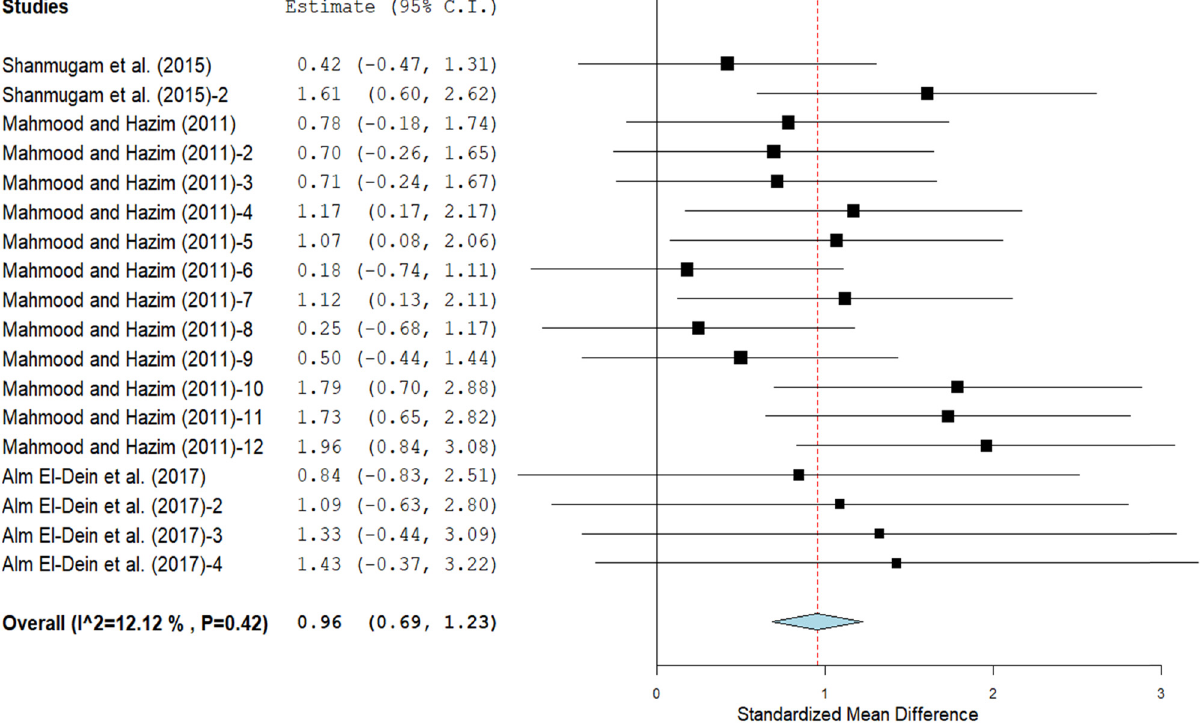
Figure 5: Impact of diets with or without zinc additive on live sperm percent. The thick vertical line is the line of no e ff ect ( i.e. SMD = 0 ) . Points to the left of this thick vertical line connote a decrease in live sperm percent, whereas points to the right depict an increase in live sperm percent. The dotted line shows the overall SMD. The result is considered signi fi cant the 95% CI of the overall SMD did not include